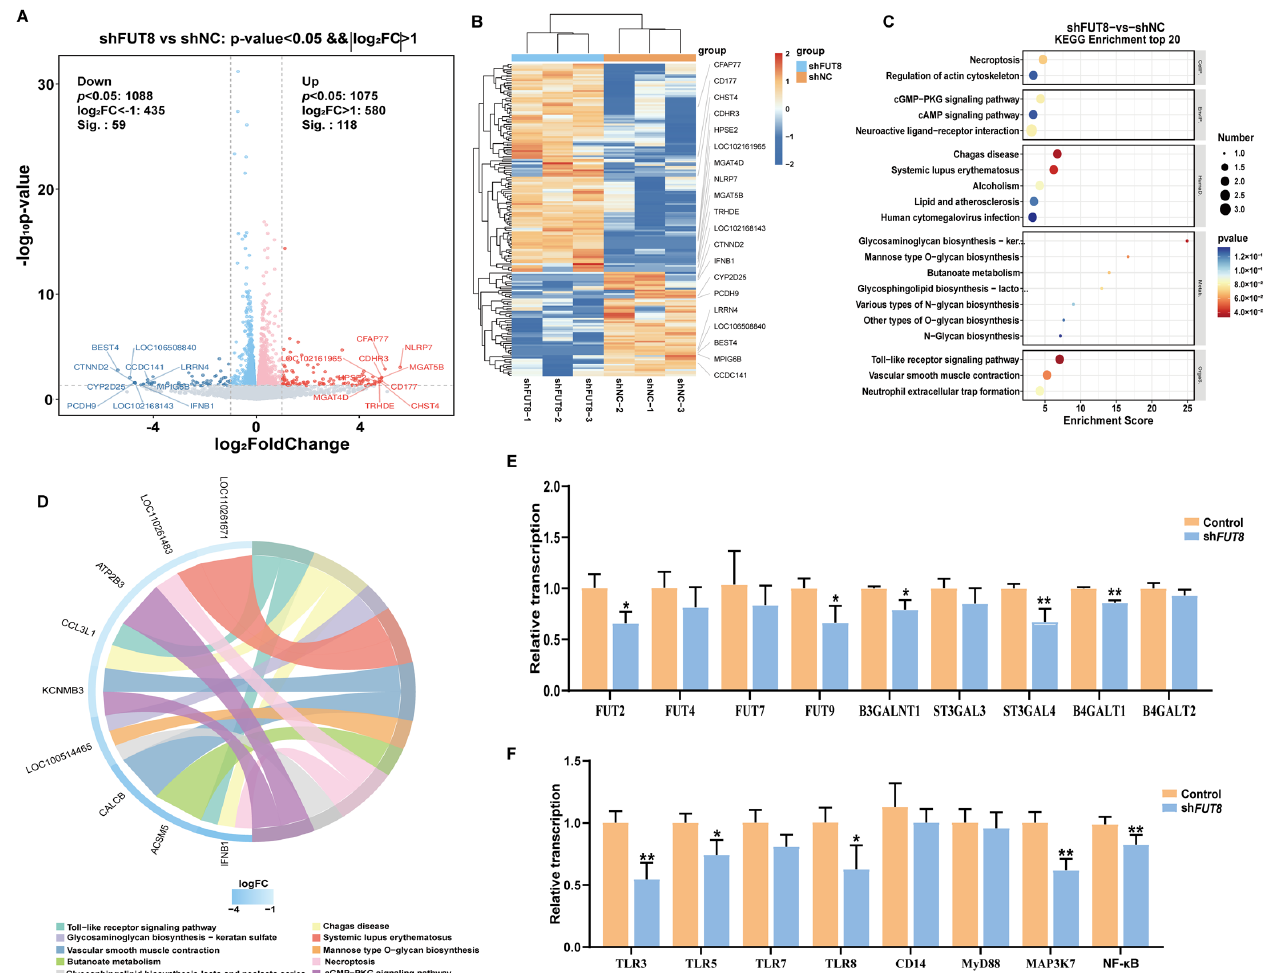
Figure 4. Identification and analysis of differentially expressed genes (DEGs) in IPEC-J2 cells fol- lowing FUT8 knockdown. ( A ) Statistical analysis of the number of up- and down-regulated DEGs identified between the shFUT8 and shNC samples. ( B ) Heat map analysis of DEGs. ( C ) KEGG path- way enrichment analysis for the DEGs. ( D ) Visualization analysis of key pathways and key DEGs. ( E , F ) Effect of FUT8 knockdown on the expression level of glycosphingolipid biosynthesis and Toll- like signaling pathway genes was analyzed using RT-qPCR testing. * p < 0.05 and ** p < 0.01.